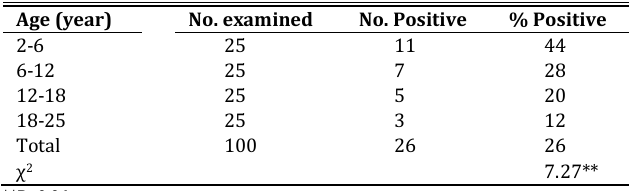
Table 1. Total of infection rate of Cryptosporidium spp. among age groups using microscope in man patients